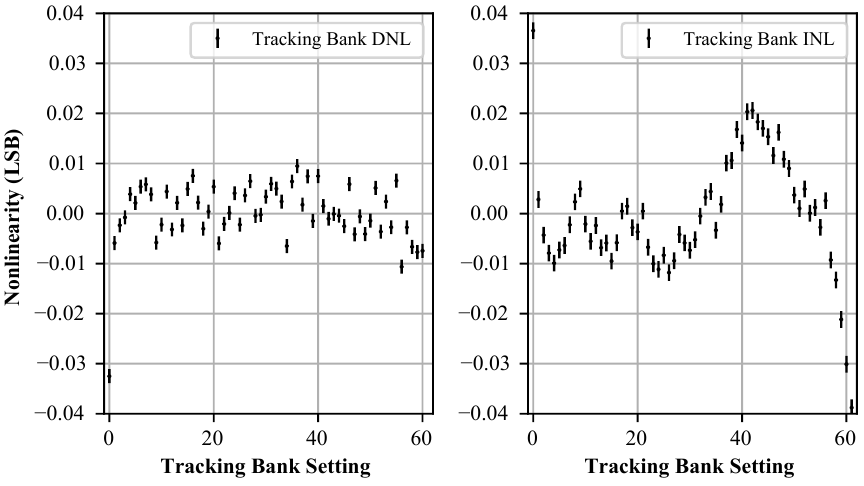
Figure 7. DCO tracking bank linearity measurements, including 95% confidence intervals. The absence of a dummy cell adjacent to cell 0 produces a small edge effect.